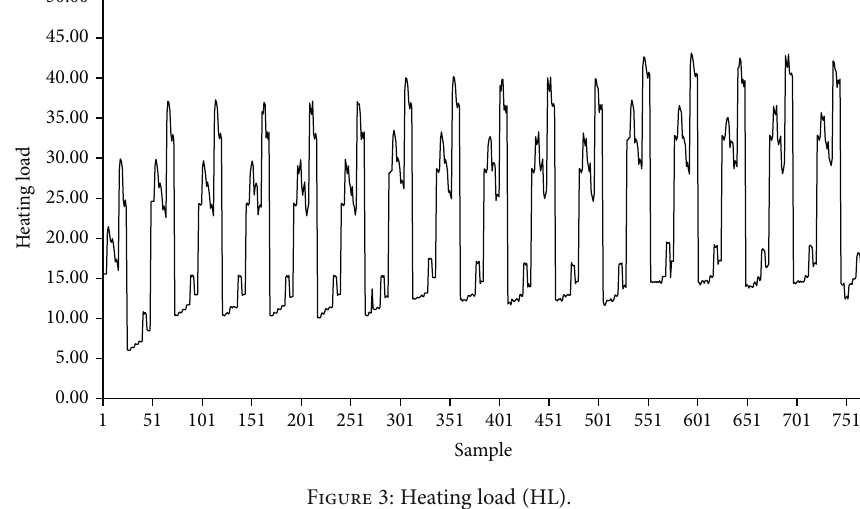
Figure 3: Heating load (HL).